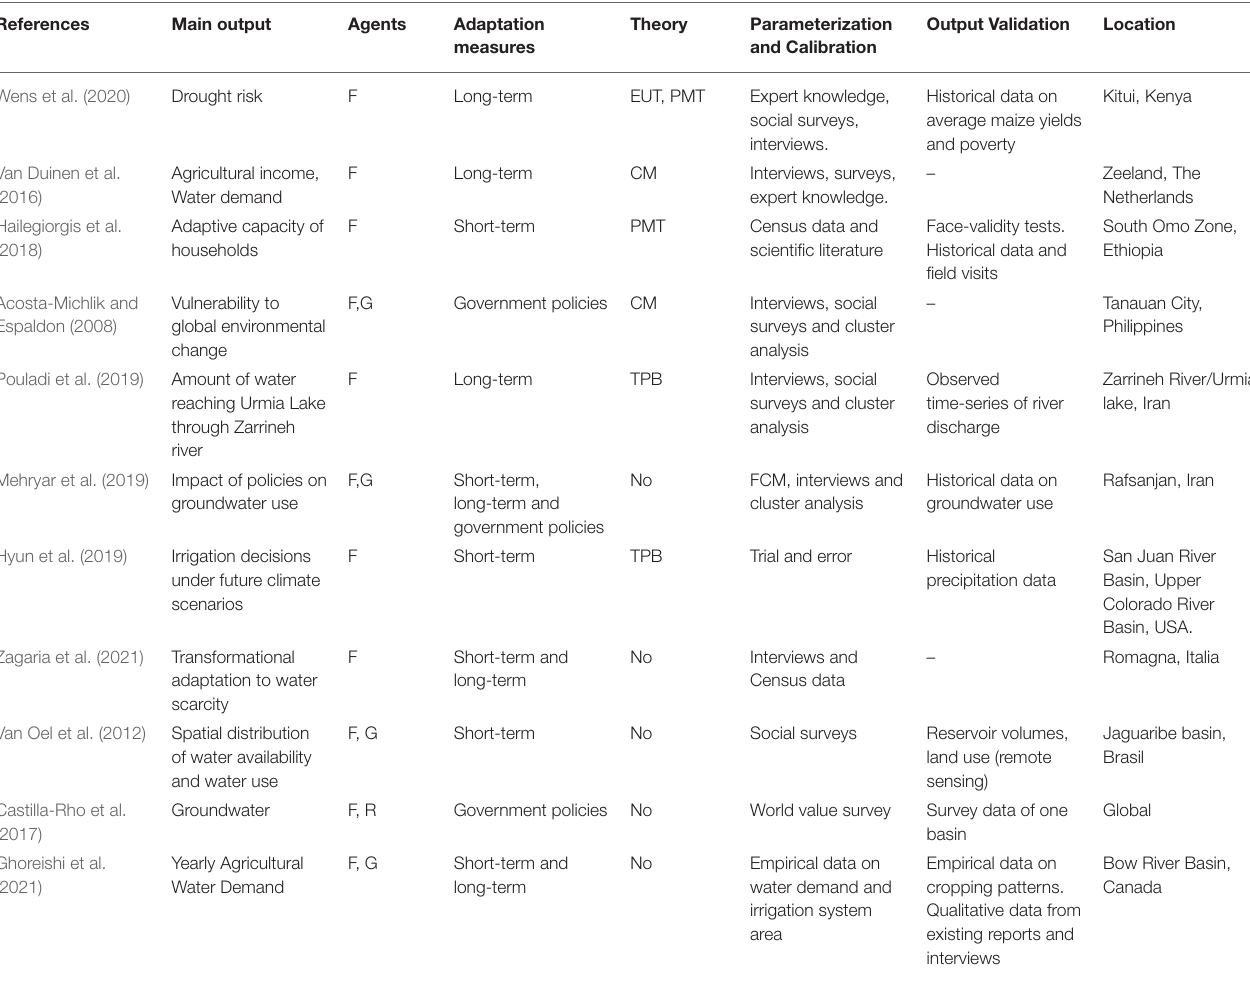
TABLE 1 | Overview of drought risk agent-based